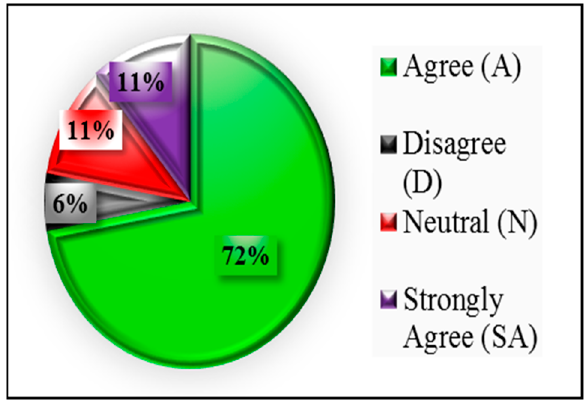
Figure 3. Proper planning and designing with agile methodology .